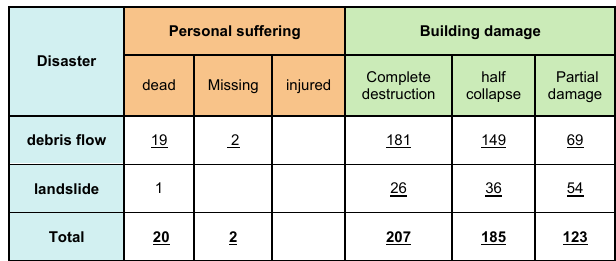
Table 2. Damage situation of the sediment disasters in Fukuoka